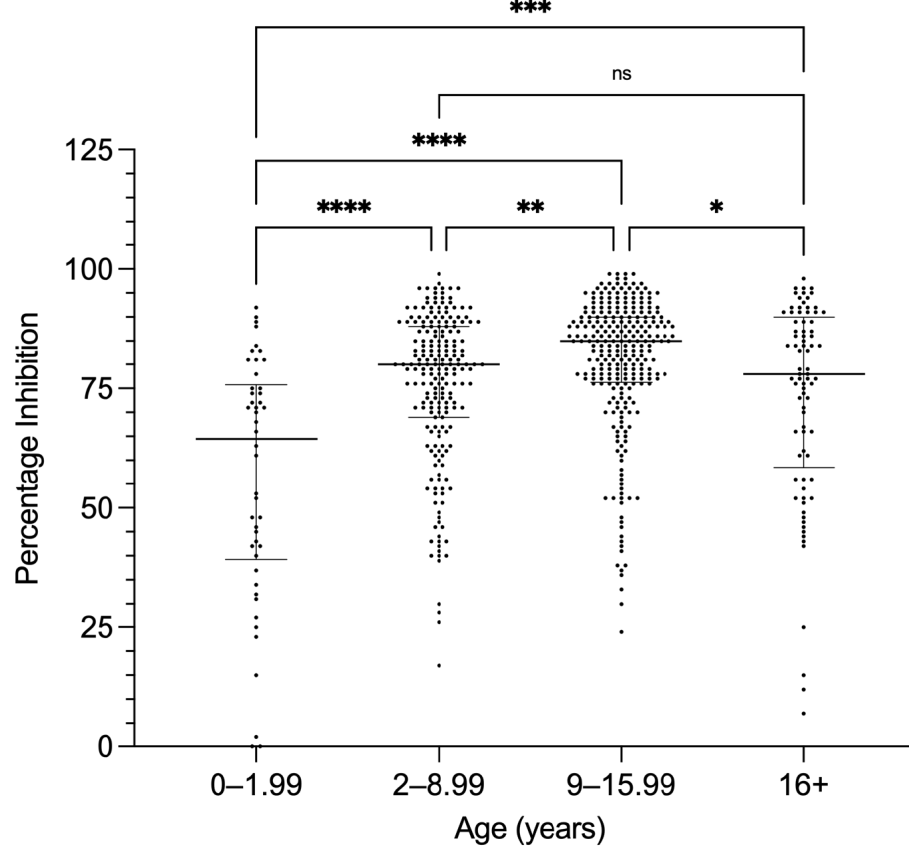
Figure 3. Distribution of PC-ELISA percentage inhibition (PI) values according to age groups (0–1.99 years, 2–8.99 years, 9–15.99 years, and 16+ years) of all camels sampled in Marsabit, Laikipia, and Machakos counties in 2020 ( n = 284) and at Isiolo and prior to slaughter at Athi River in 2015 ( n = 323) for which age was recorded. Median PI (widest horizontal line) increased significantly with age up to 15.99 years, thereafter showing a small but significant decrease. Data were analysed by a Kruskal–Wallis test, with Dunn’s post hoc test for pairwise comparisons. * p = 0.0294, ** p = 0.0011, *** p = 0.0003, **** p < 0.0001.